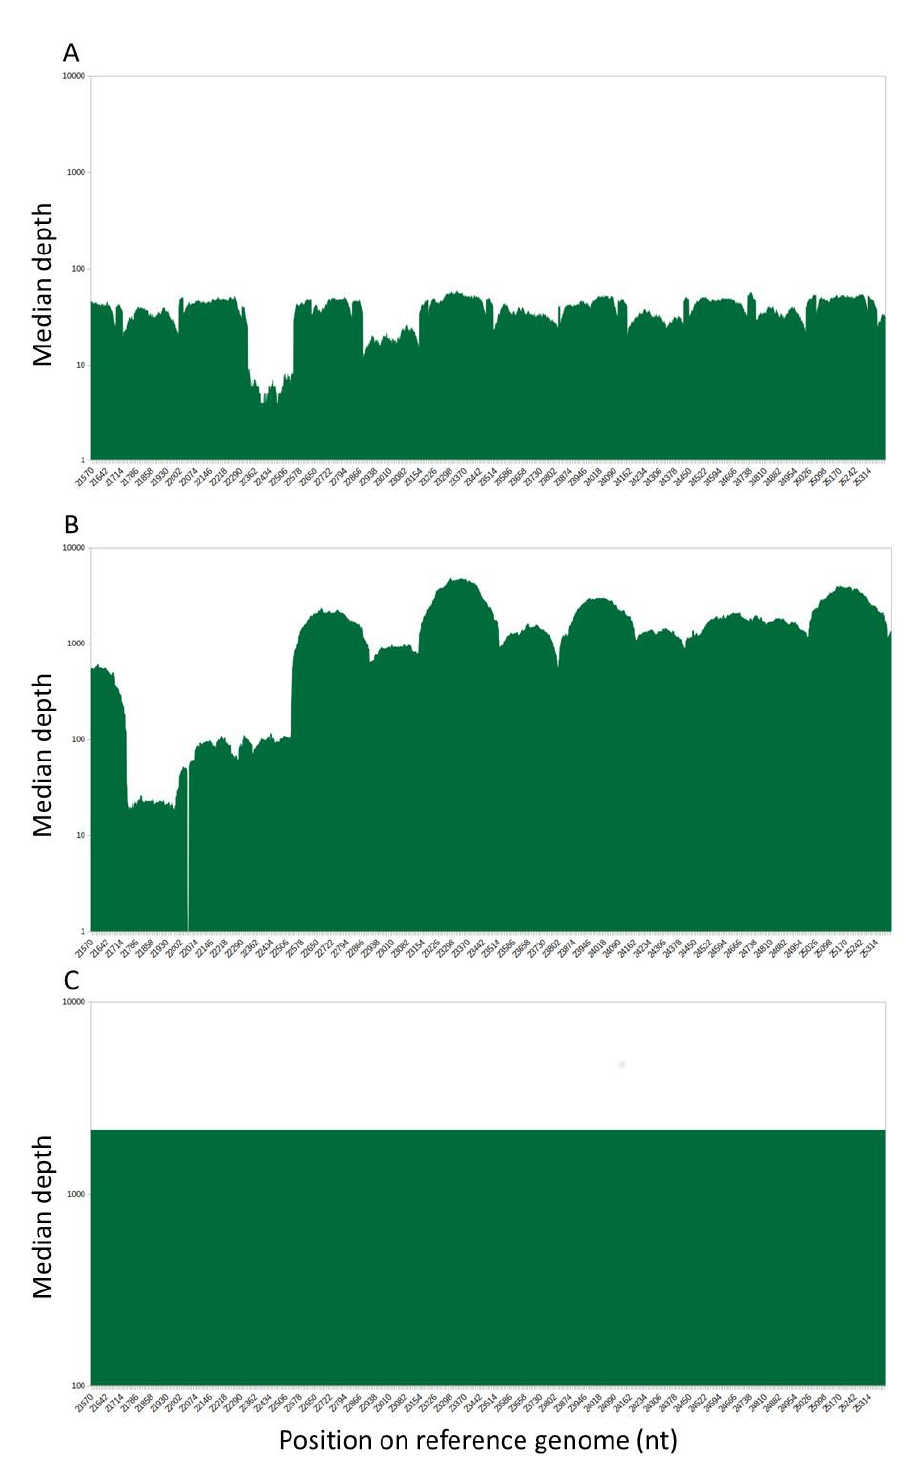
Figure 1. Sequencing depth over the spike gene with Illumina COVIDseq protocol. Logarithmic representation of the number of reads mapped on the reference genome, zoomed on the spike region. The x-axis was labeled from 21563 and 25384, corresponding to the positions on the complete genome. ( A ). Sequencing depth over the spike gene with Illumina COVIDseq protocol with singled-end 35 nt read-length sequencing and ( B ) paired-end 150 nt read-length sequencing. ( C ) Sequencing depth over the spike gene with PacBio